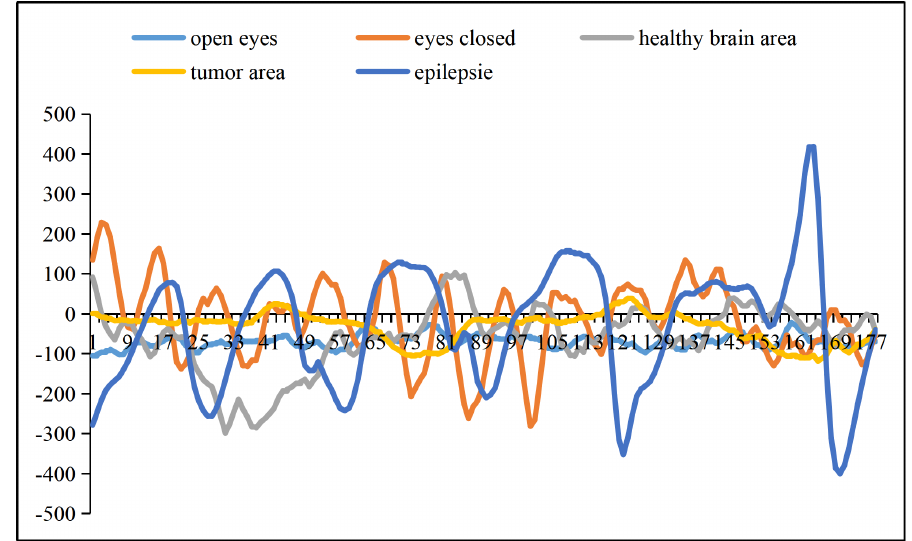
Figure 1. The raw electroencephalogram signal waveform of one epileptic seizure condition and four normal conditions.